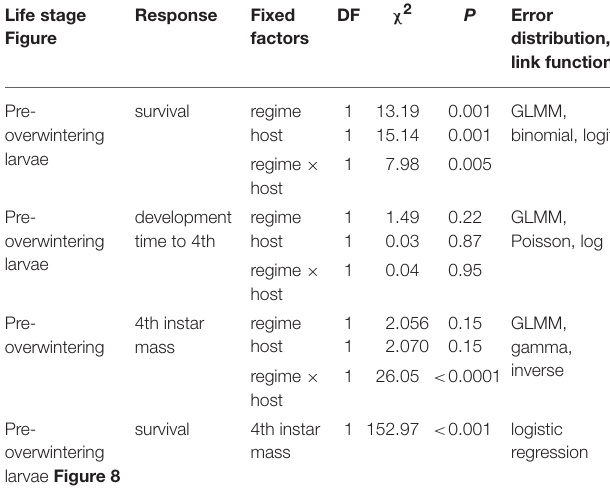
TABLE 3 | GLMM and logistic regression summaries for the combined effects of cold stress and host plant on survival and development time of pre-overwintering